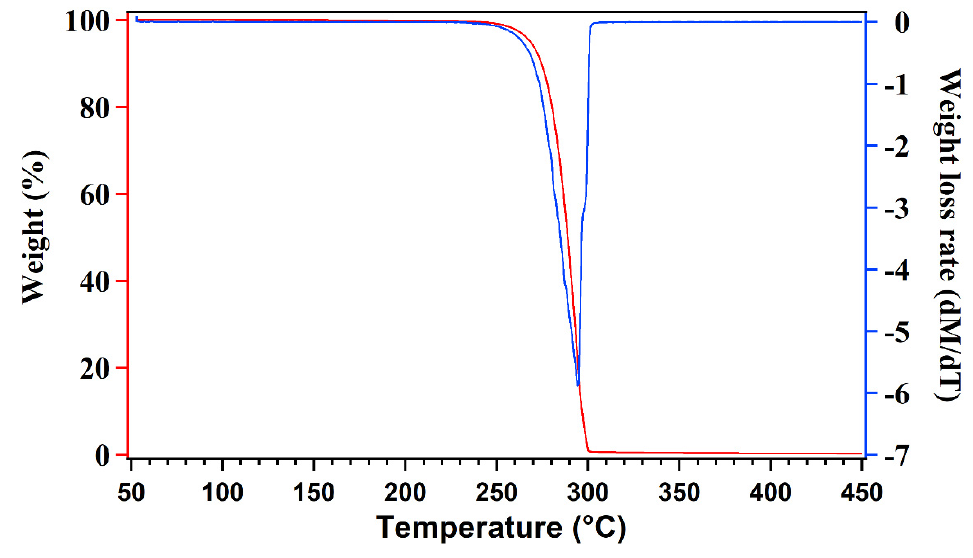
Figure 1. TGA (red) and DTG (blue) curves of P − 0.